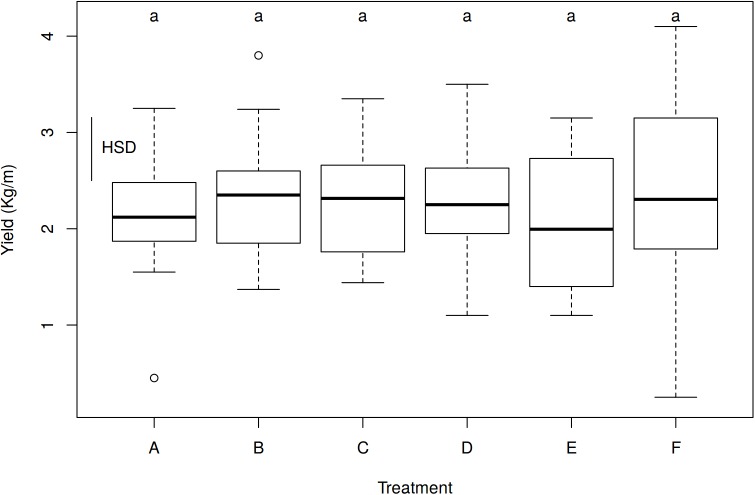
Effect of treatments on yield (kg/m) with all the data (102 degrees of freedom).Treatments are noted as (A) Urtica slurry RD; (B) Urtica slurry 1/2 RD; (C) Urtica slurry 2 RD; (D) Urtica + Equisetum slurry; (E) conventional foliar manure; (F) control treatment. HSD, honestly significant difference = 0.6554 kg/m. Boxes show the 25th and 75th percentiles. Lines in the boxes show the median values; columns with the same letter do not differ significantly from each other at p ≤ 0.05 (HSD).